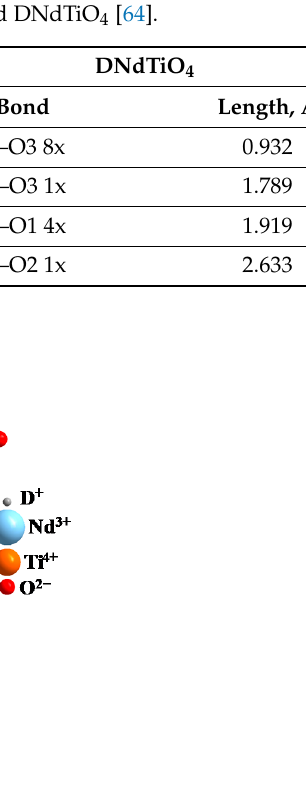
Figure 5. Comparison of the HNdTiO 4 (this work) and DNdTiO 4 (data from [64]) structures. The equivalent positions of hydrogen and deuterium are connected by lines.